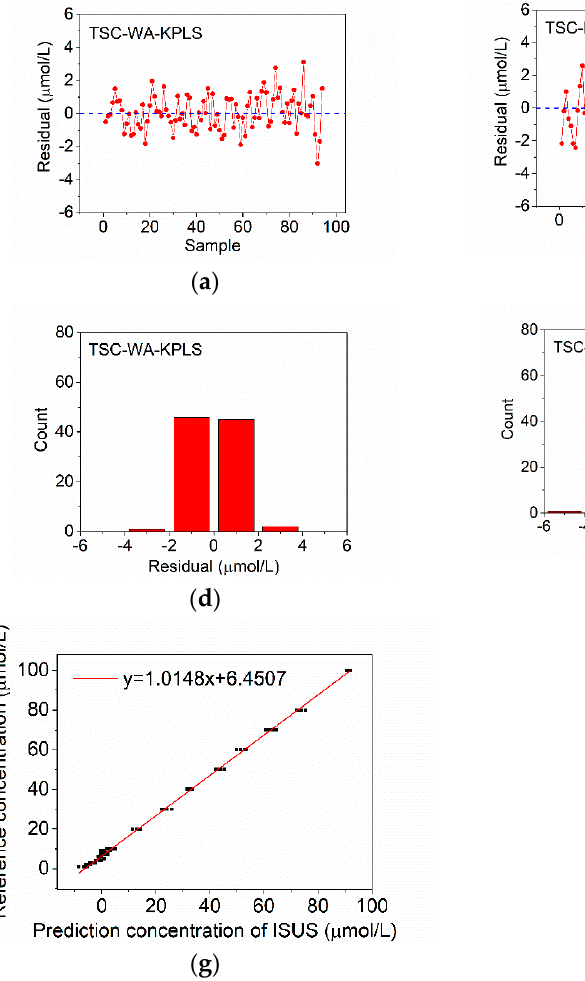
Figure 9. Prediction results of seawater samples from Western Pacific. ( a ) Residual of TSC-WA-KPLS algorithm; ( b ) residual of TSC-MLR algorithm; ( c ) residual of ISUS algorithm after linear calculation; ( d ) frequency count of TSC-WA-KPLS; ( e ) frequency count of TSC-MLR; ( f ) frequency count of ISUS model after linear calculation; ( g ) linear correction for ISUS algorithm. Table 2. Prediction results of different